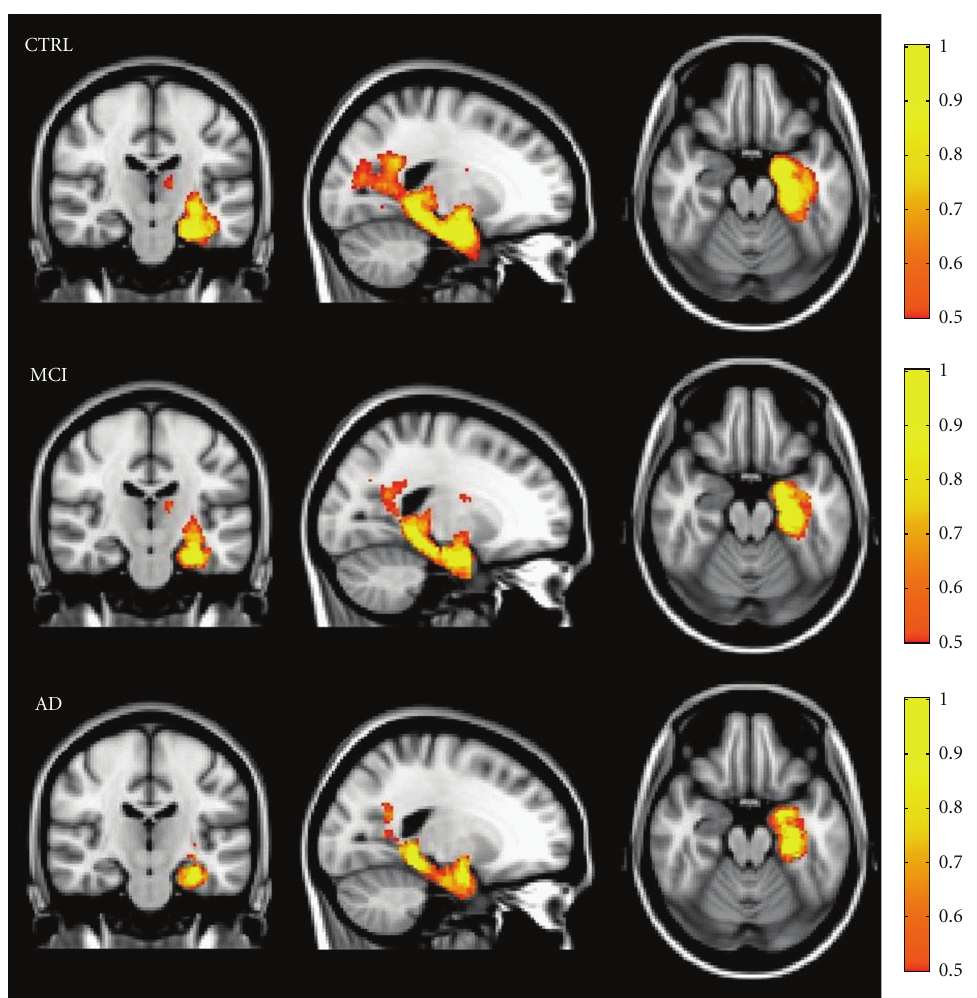
Figure 3: Variability maps for the tract connecting hippocampus with PC/PCC (on MNI152 T1-weighted template) in each subjects group. The color intensity indicates the percentage of subjects in whom the tract passes through each voxel. A yellow color scale indicates the higher degree of overlap among subjects; a red-orange color scale indicates that tract is present only in half of the subjects.